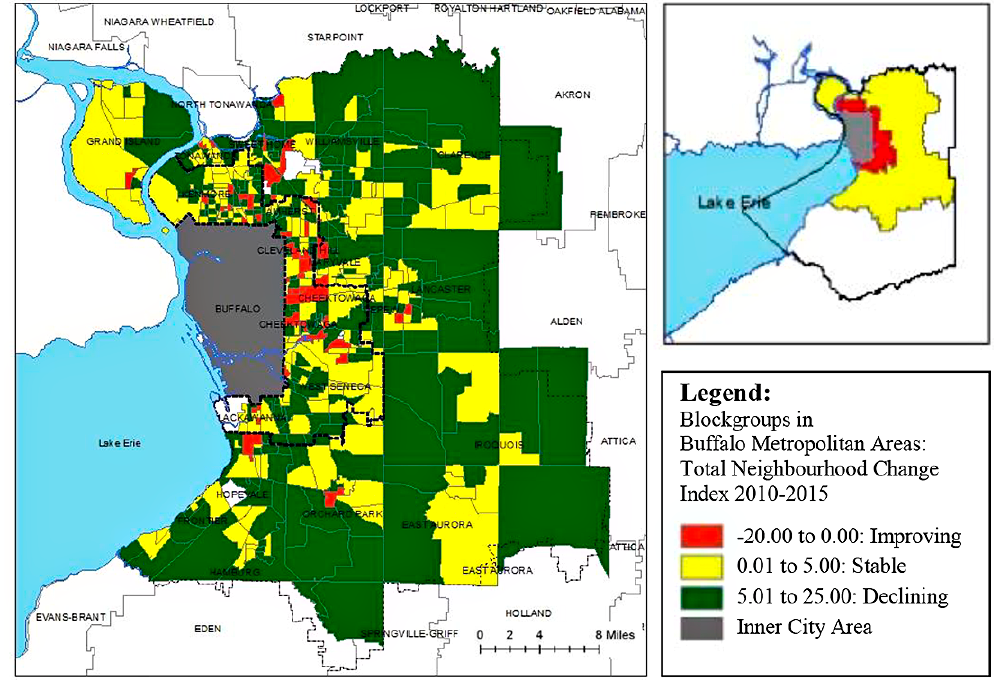
Figure 5. Overall Neighbourhood Change Index between